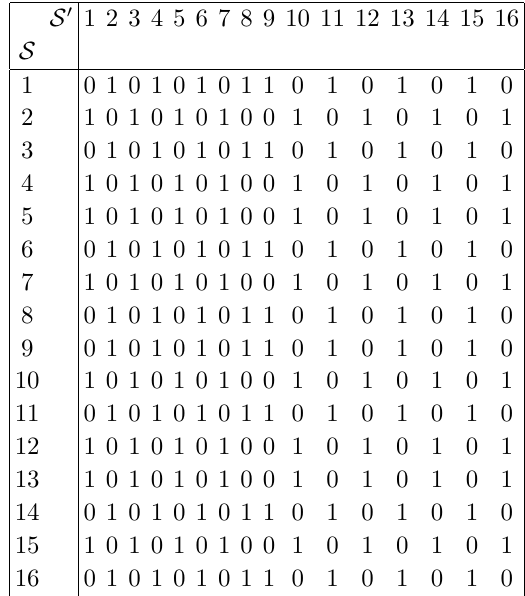
Table 34 . Gadget values for P